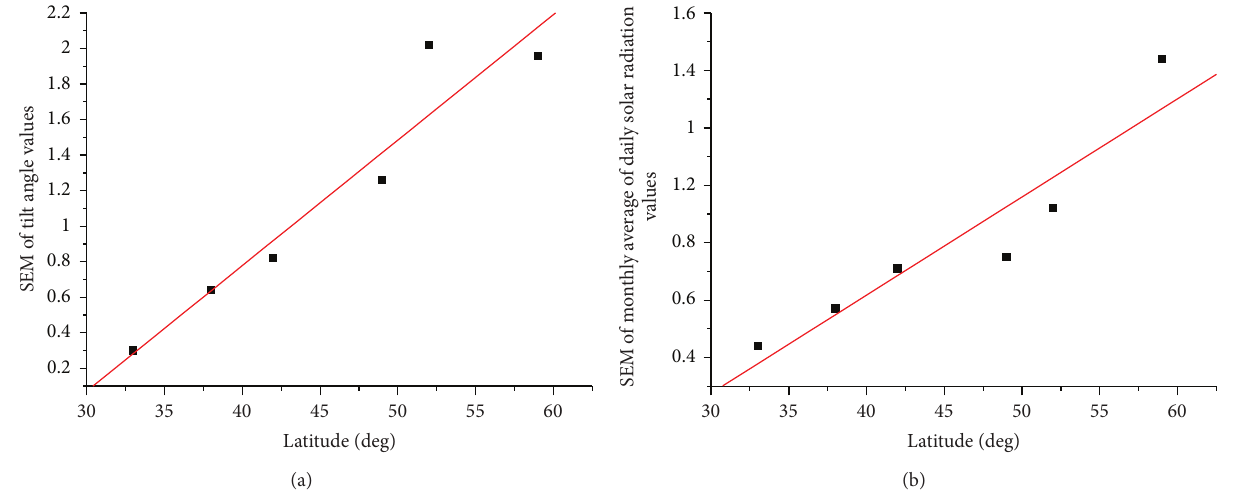
Figure 2: The standard error of the mean (SEM) of the tilt angle values (a) and of the monthly average of the daily global solar radiation values (b), computed for the summer months (solar declinations 𝑑 4 – 𝑑 9 ) as a function of latitude. The linear fits provided the correlation coefficients 𝑟 = 0.956 and 𝑟 = 0.935 ,